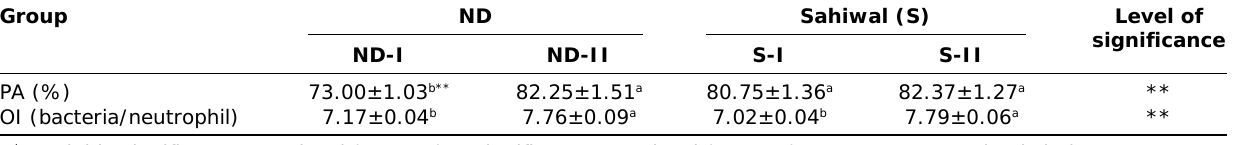
Table-1: Phagocytosis in ND and Sahiwal cattle according to breed and age.